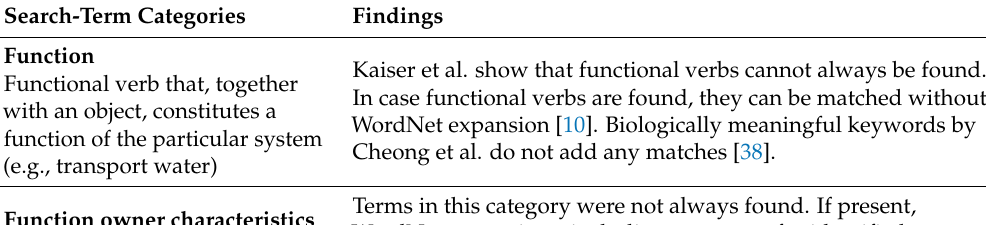
Table 1. Categories of terms used to annotate predetermined pairs of biological and technical texts. For each pair, the subject of the biological text could possibly result in a biomimetic solution for the